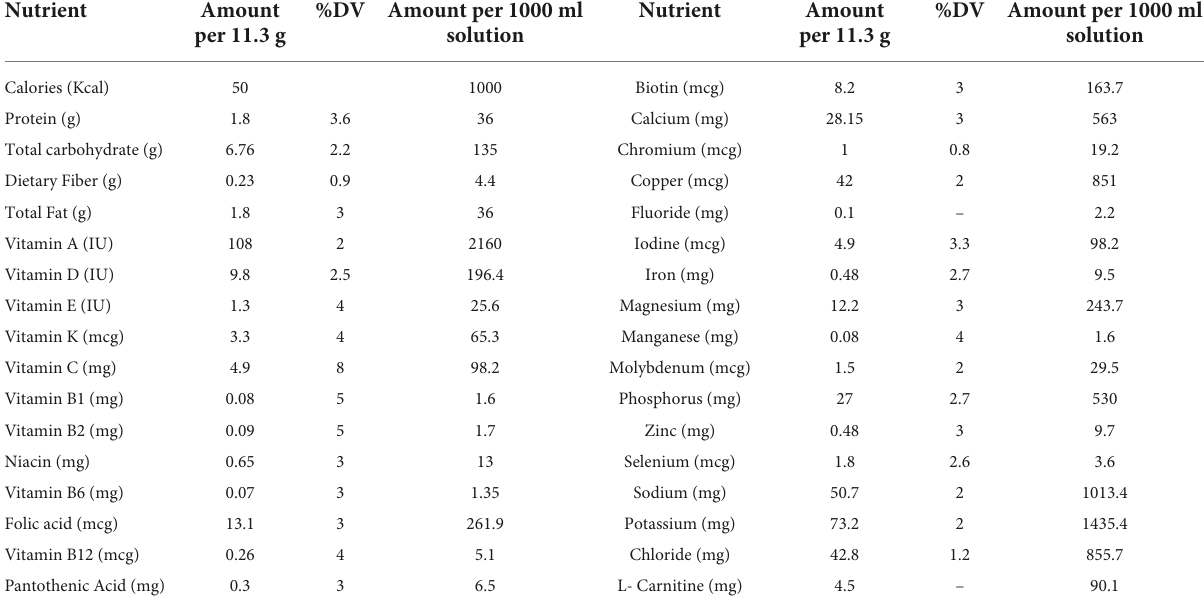
TABLE 1 Contents of patients enteral